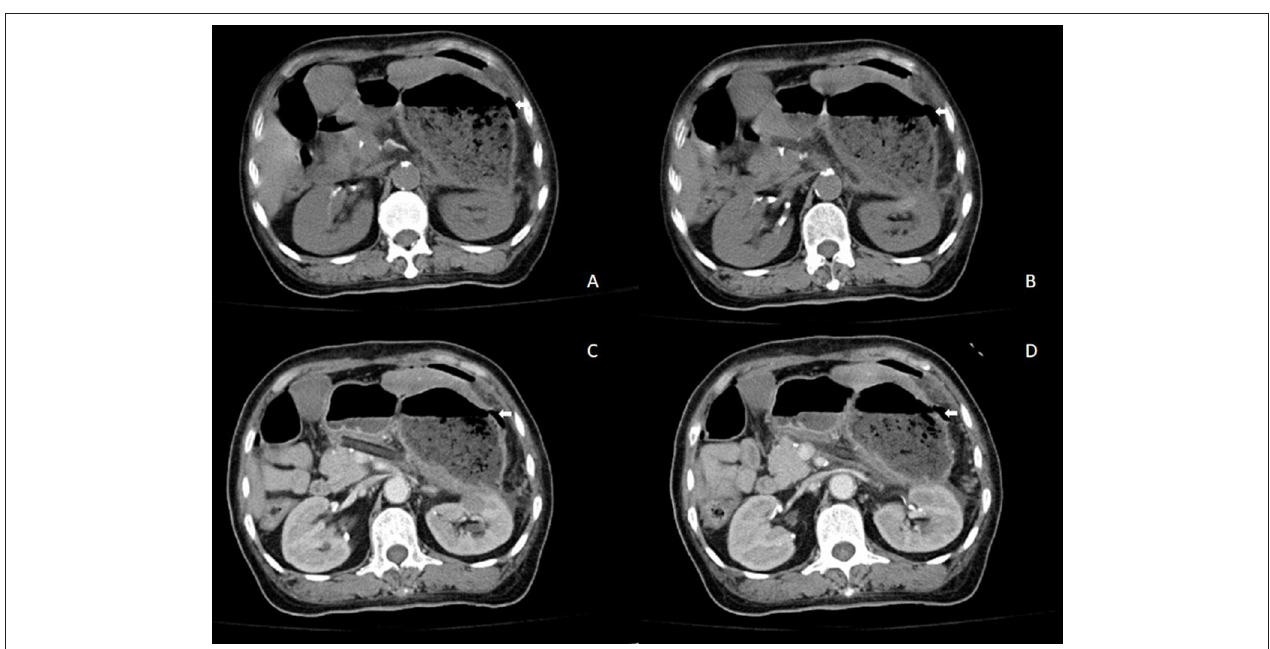
FIGURE 3 | Results of contrast-enhanced abdominal CT when the patient suddenly presented with acute abdominal pain. (A,B) Abdominal CT and (C,D) contrast-enhanced abdominal CT showing free intraperitoneal air and suspected discontinuity of the wall of greater gastric